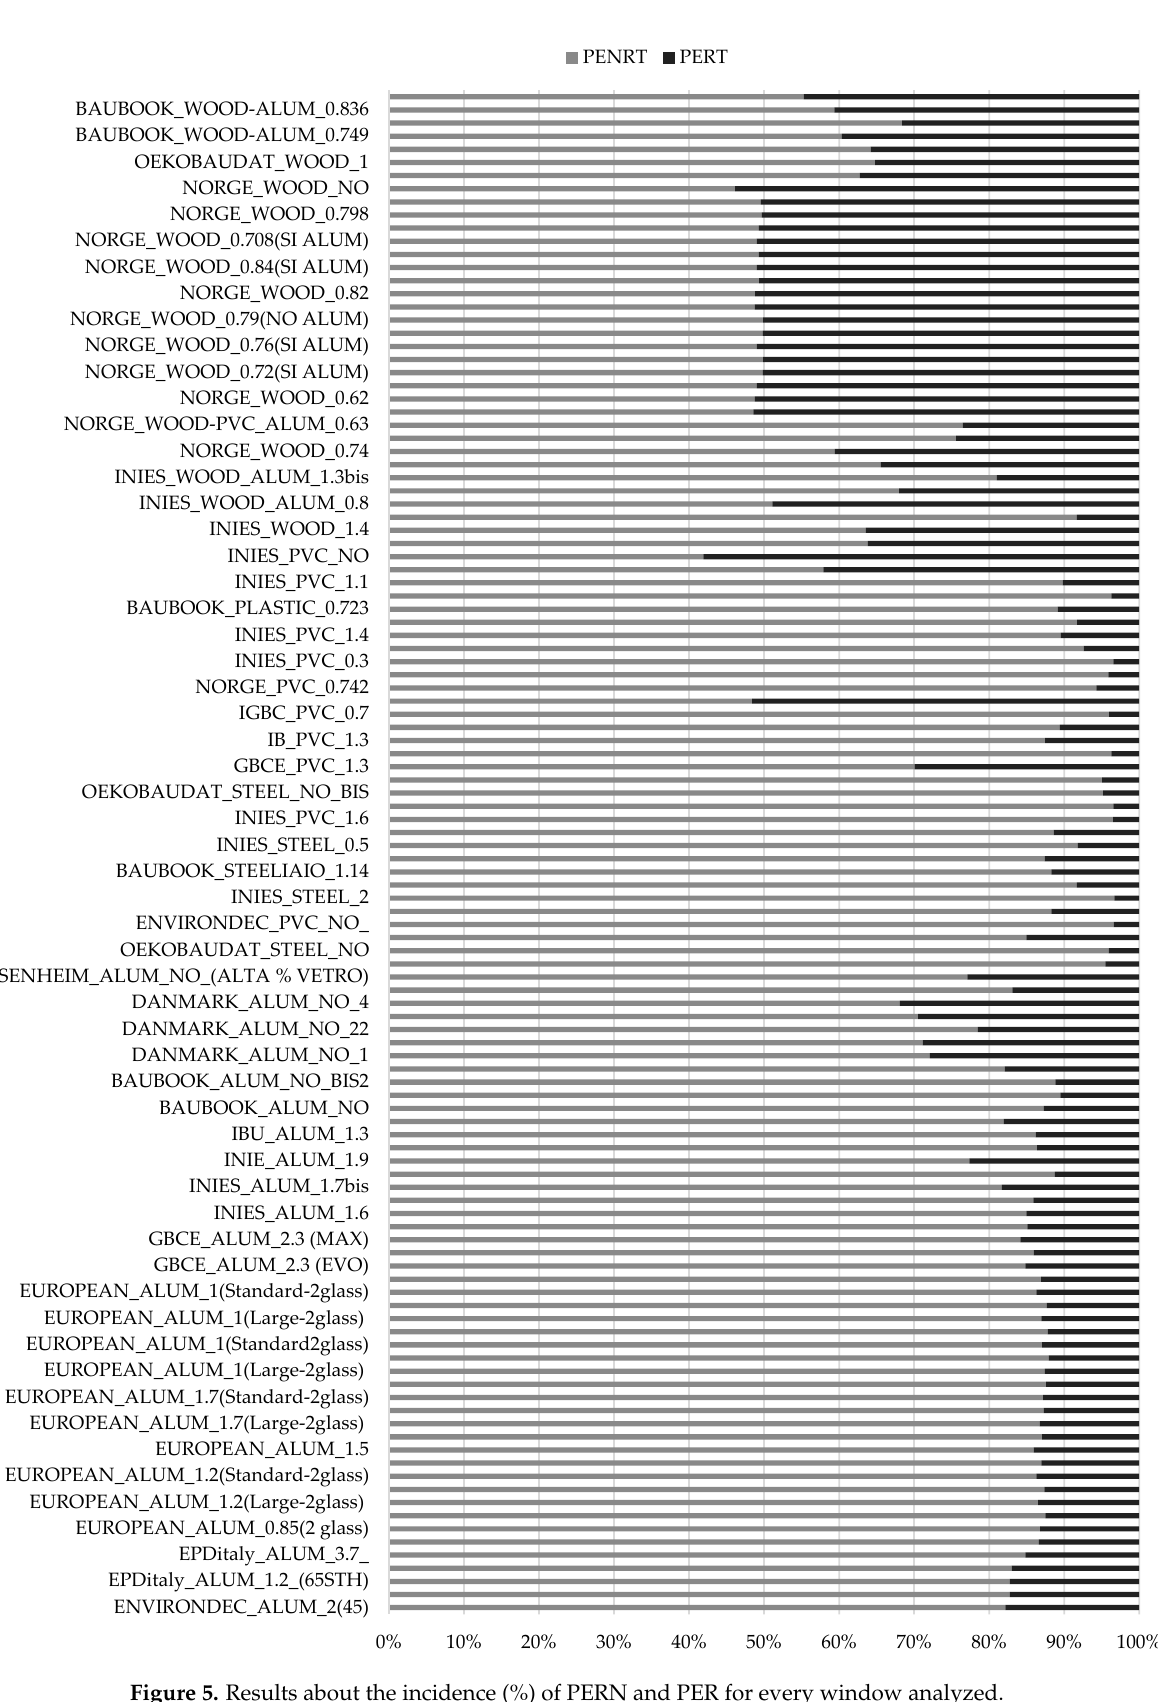
Figure 5. Results about the incidence (%) of PERN and PER for every window analyzed.